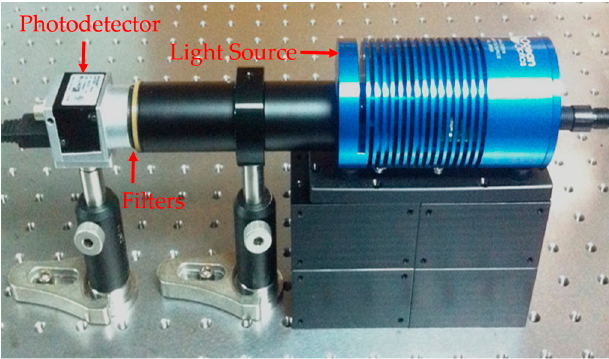
Figure 2. The experimental optical system.